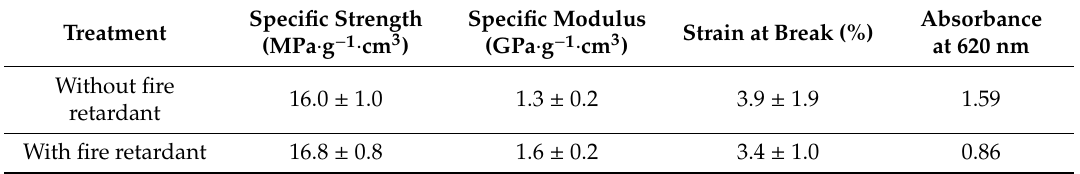
Table 1. Flexural properties of treated and untreated panels and the UV absorbance value for the two